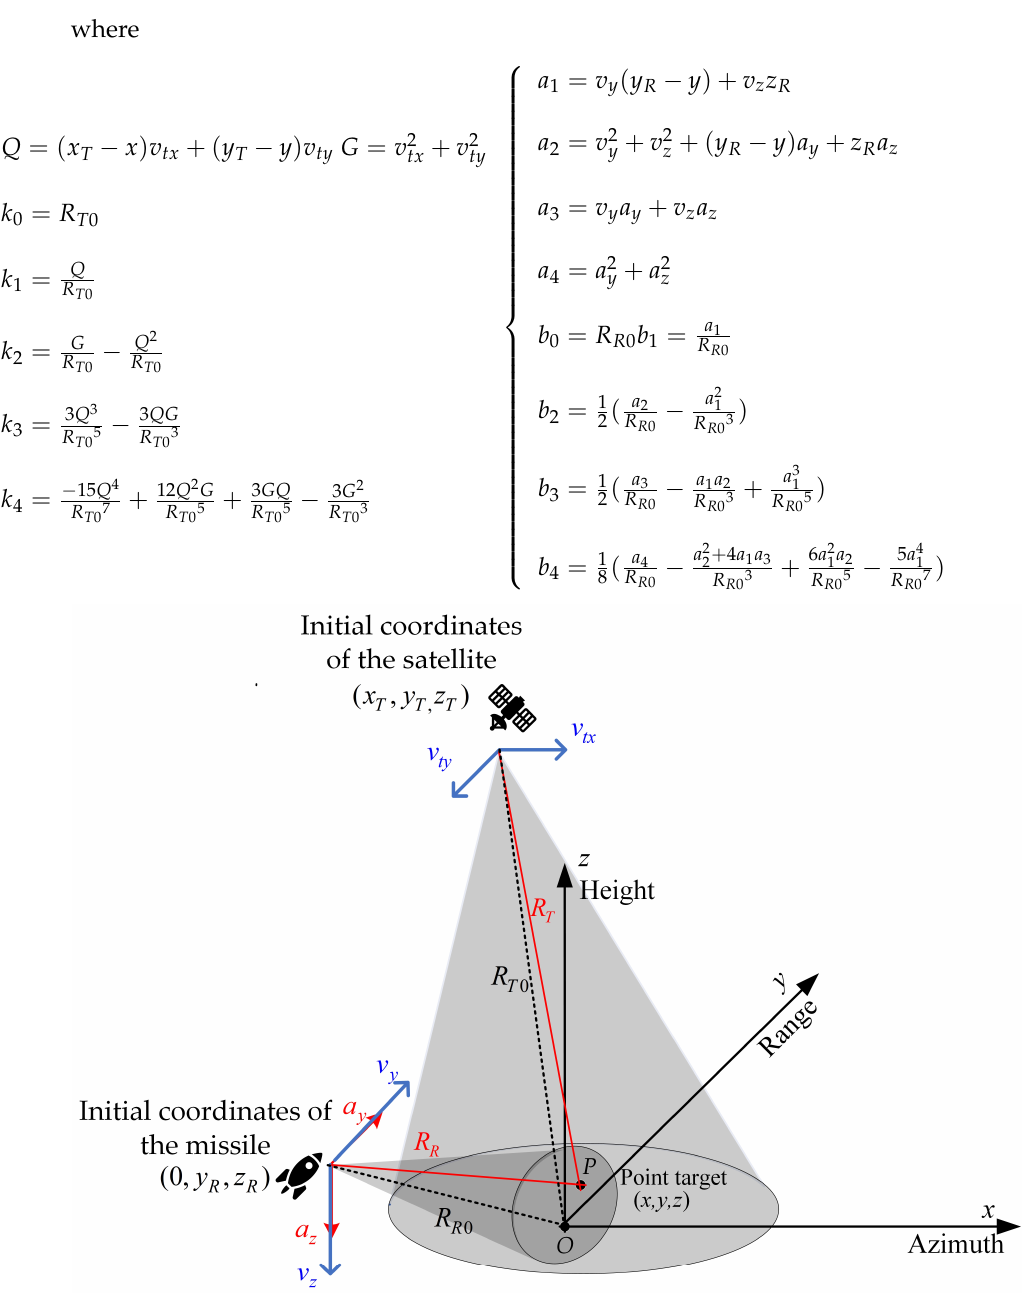
Figure 1. Geometry configuration of spaceborne missile bistatic SAR.